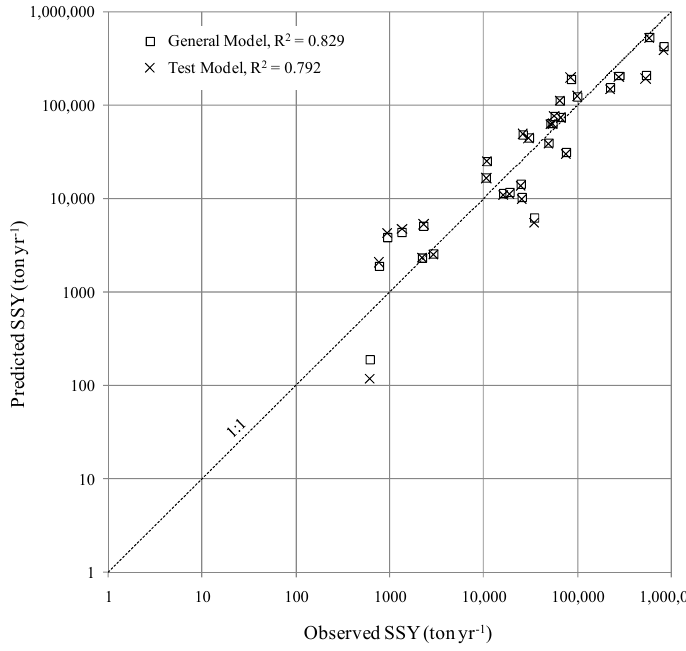
Figure 2. The general (for Equation (7)) and test models’ correlation diagram of predicted versus observed SSY.